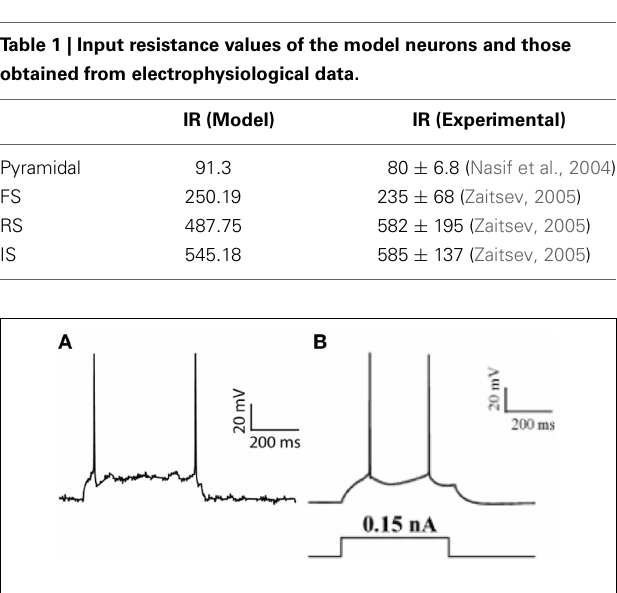
FIGURE 1 | Pyramidal neuron model validation. (A) Model response to a current-step pulse at the soma (0.17nA). (B) Experimental response of a PFC layer V pyramidal neuron to a current step-pulse (adapted from Nasif et al.,